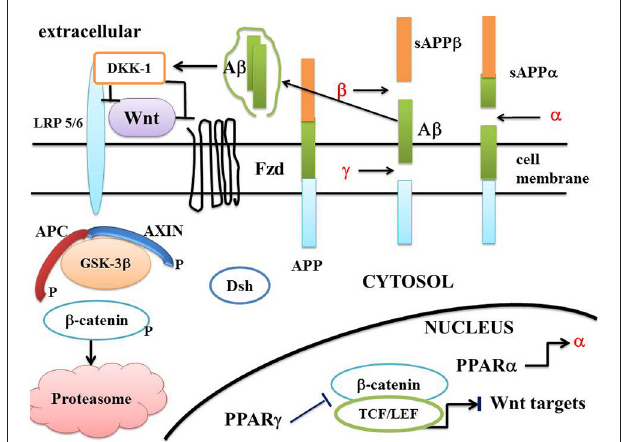
FIGURE 2 | A schematic model of the Wnt/beta-catenin pathway in Alzheimer disease. In AD, the “on state” of canonical Wnt/beta-catenin pathway is interrupted at two potential levels. Firstly, extracellular A β activates DKK1 which inhibits the interaction between Wnt and LRP 5/6. Binding of Wnt to Fzd is suppressed and Dsh dissociates from Fzd/Axin and migrates to the cytosol. The recruitment of the destruction complex to the plasma membrane is suppressed. Inactivation of Dsh leads to stimulation of GSK-3 β . Thus, APC and AXIN interact with GSK-3 β and beta-catenin (Wnt “off state”). Beta-catenin is phosphorylated by GSK-3 β . The destruction complex AXIN/APC/GSK-3 β is activated and enhances the destruction process of beta-catenin in the proteasome. Secondly, PPAR gamma which is activated by agonists can inhibit the beta-catenin/TCF/LEF complex in the nucleus, thus inhibiting the transcription of Wnt target genes. Amyloid precursor protein (APP) can be cut into various fragments by α , β , and γ secretases. PPAR α activates the transcription of α secretase. Abbreviations APC, adenomatous polyposis coli; Dsh, Disheveled; Fzd, Frizzled; GSK-3 β , glycogen synthase kinase-3beta; LRP5/6, low density lipoprotein receptor-related protein 5/6; TCF/LEF, T-cell factor /lymphoid enhancer factor; sAPP α , soluble APP α ectodomain; sAPP β , soluble APP β ectodomain; APP, Amyloid precursor protein; α , β , and γ , α , β , and γ secretases; A β , amyloid β peptide; DKK1, Dickkopf-related